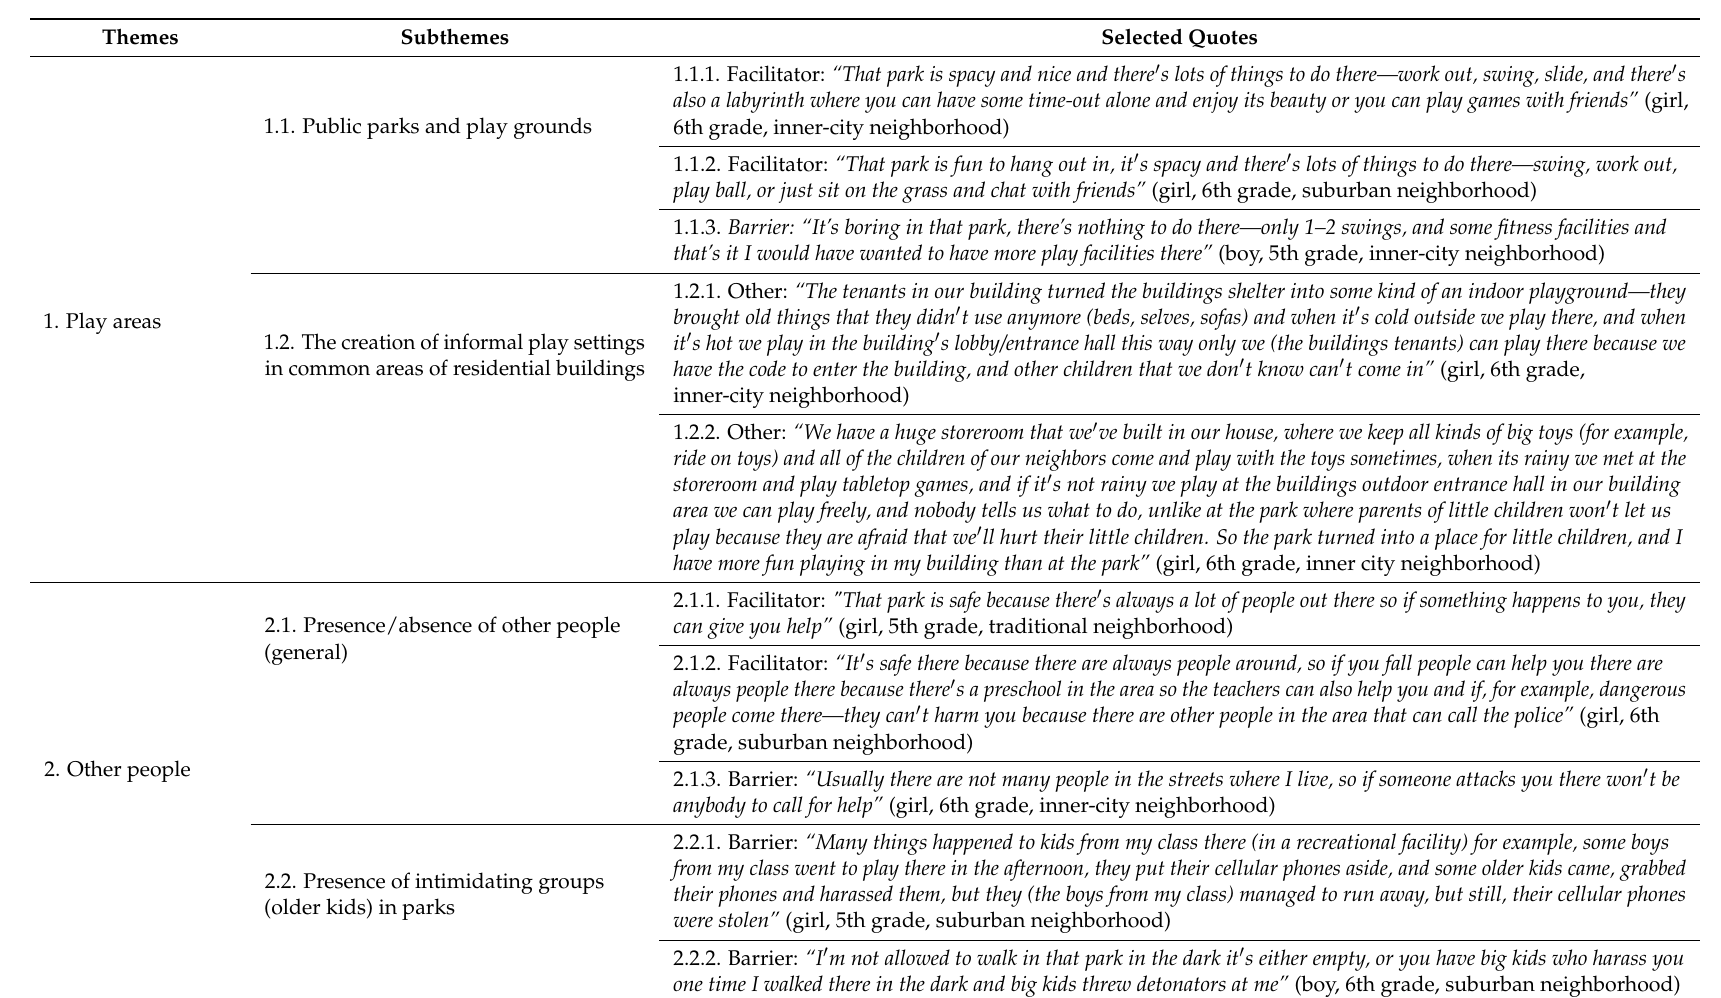
Table 4. Findings from semi-structured interviews—themes, subthemes and selected